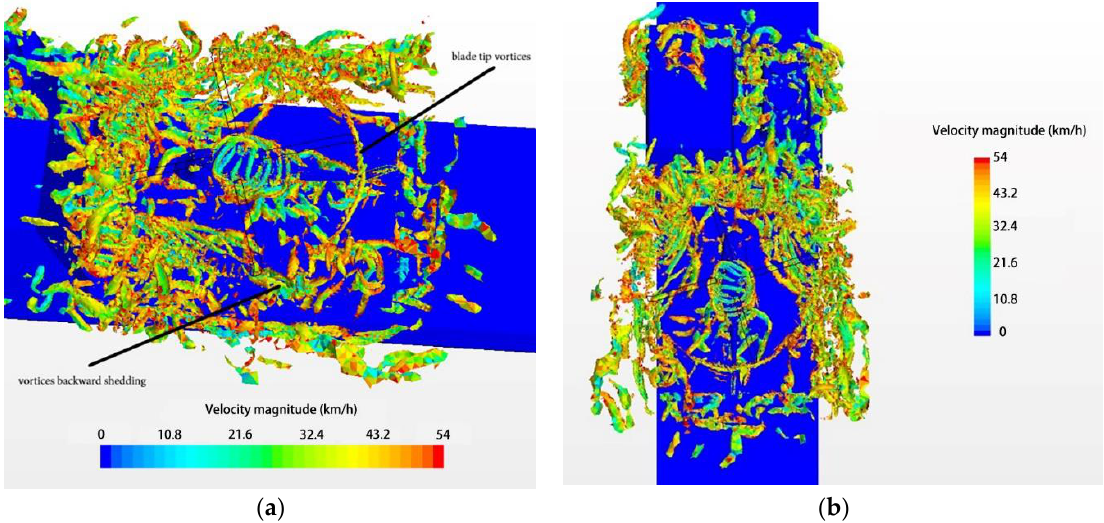
Figure 15. Vortex nephogram under 0° and 60 km/h WOD condition. ( a ) Near the flight deck. ( b ) Overhead view of the flight deck.